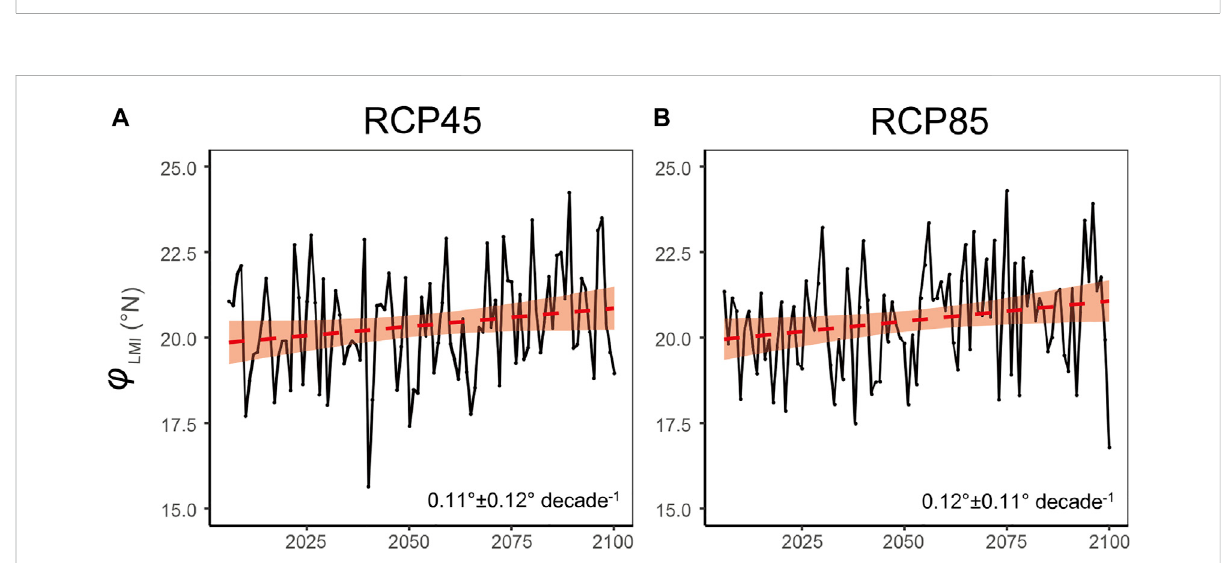
FIGURE 4 ProjectedmigrationsoftheWNPTCinfutureunderthetworepresentativeemissionscenarios.Timeseriesofannual-mean φ LMI fromWNPTCs explicitly generated in the 14 CMIP5 twenty- fi rst-century (A) RCP4.5 and (B) RCP8.5 projection